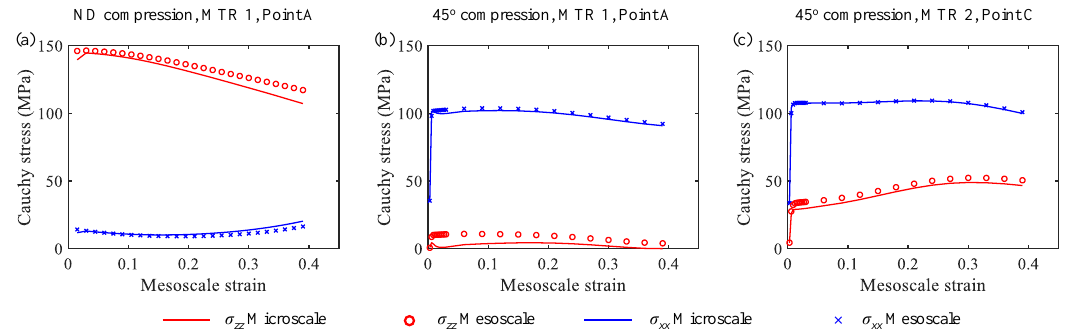
Figure 10. Local stress–strain curve comparison between mesoscale and microscale